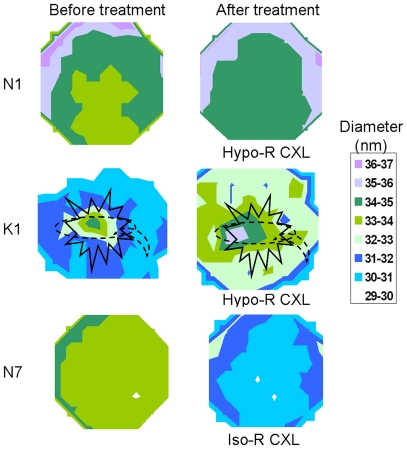
Changes in collagen fibril diameter following Riboflavin/UVA cross-linking.The contour maps show collagen fibril diameter in an unswollen normal (N1) and keratoconus (K1) cornea before and after hypo-osmolar riboflavin/UVA collagen cross-linking (Hypo-R CXL) and an unswollen normal cornea (N7) before and after iso-osmolar riboflavin/UVA collagen cross-linking (Iso-R CXL). The centre of each corneal button corresponds approximately with the centre of each map. The locations of the stellate scar (solid line) and the scar at Descemet's membrane level (broken line) (as recorded schematically by the operating surgeon) have been superimposed onto the contour maps of K1.